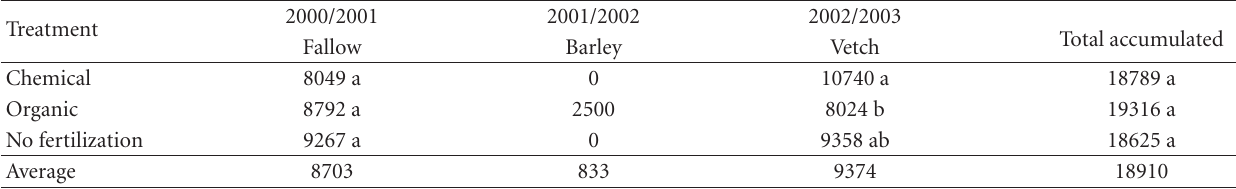
Table 3: Total inputs of organic matter (kgha − 1 ) incorporated into the soil over the period